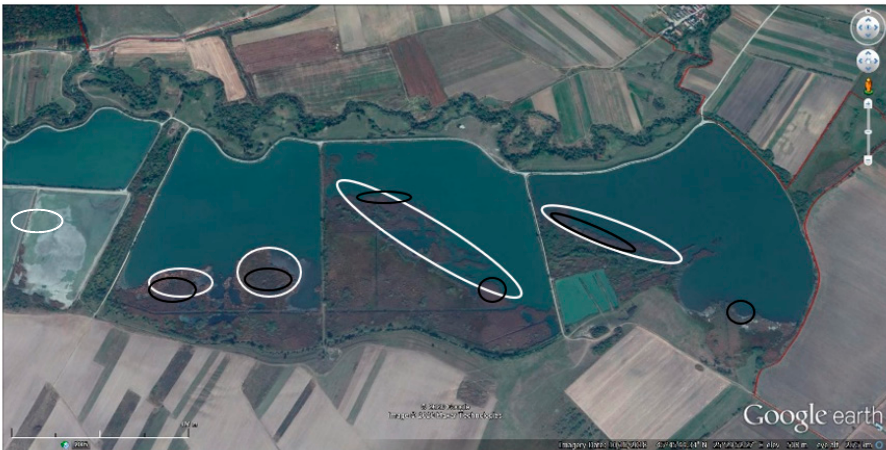
a, 2010–2020 (white oval, A. cinerea ; black oval, ,